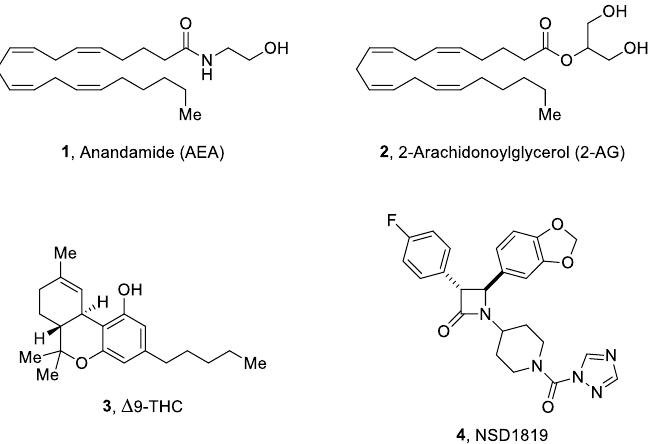
Figure 1. The structures of endocannabinoids AEA ( 1 ) and 2-AG ( 2 ), the natural cannabinoid Δ9 - THC ( 3 ), and the title compound NSD1819 ( 4 ).